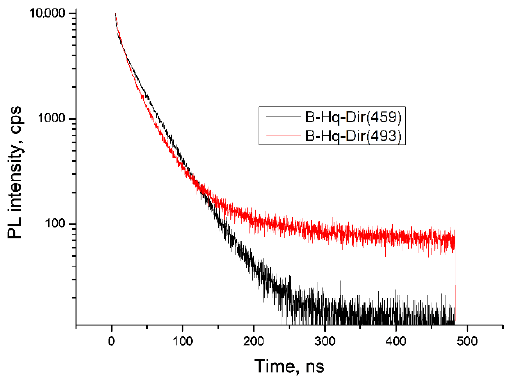
Figure 6. PL spectra of BLC obtained by heterophase synthesis.